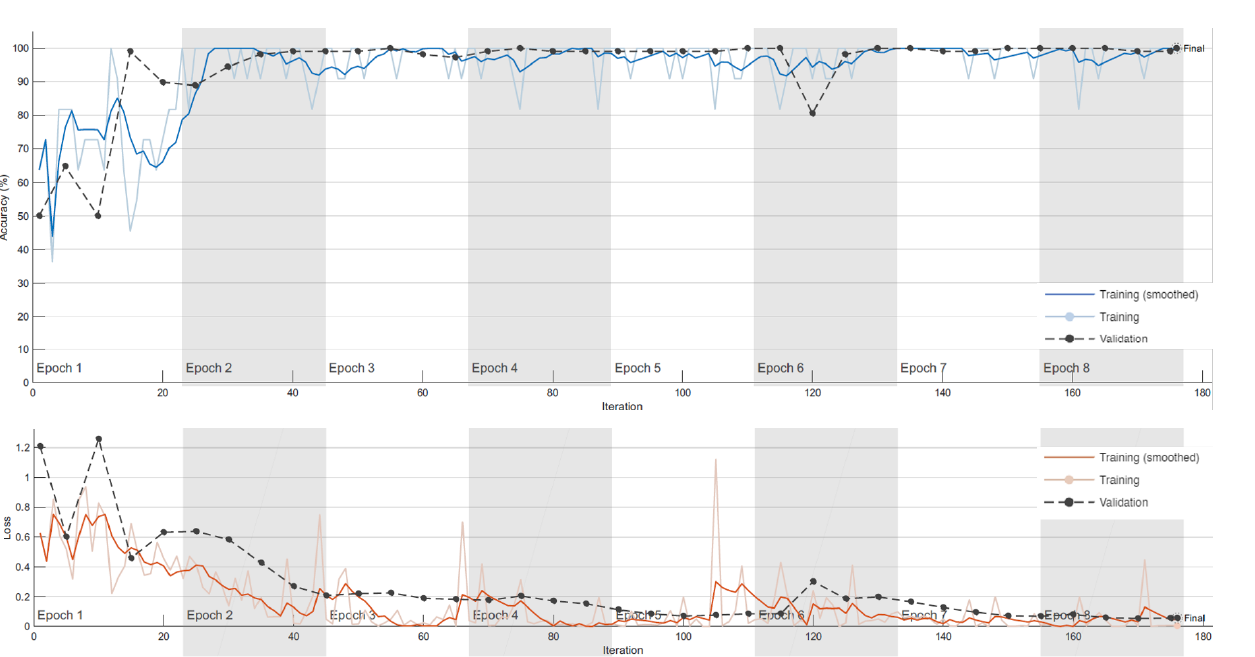
Table 3. Machine Learning-based methods for fault diagnosis.